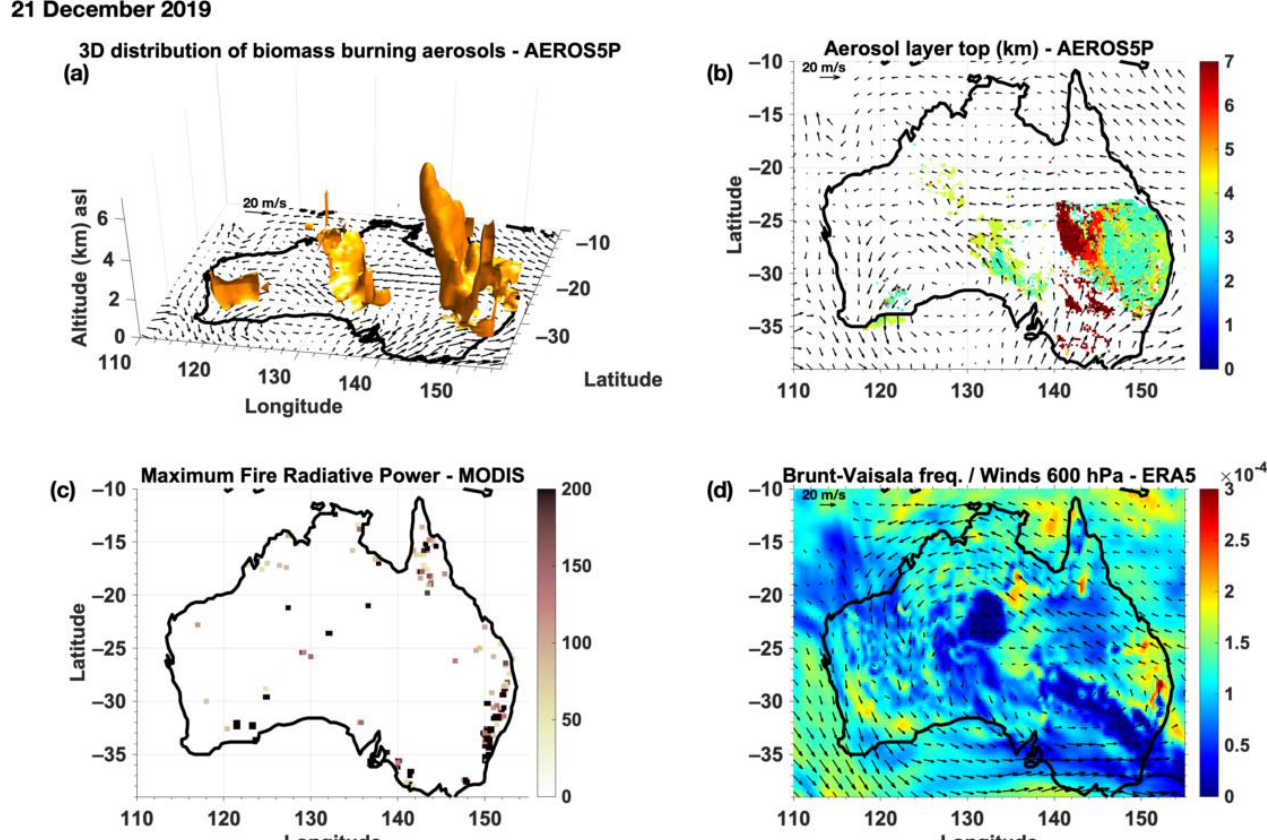
Figure 7. Same as Figure 6 but for 21 December 2019.